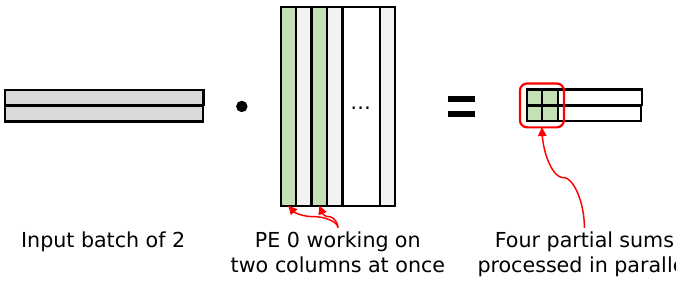
Figure 6. Output stationary accelerator architecture for large